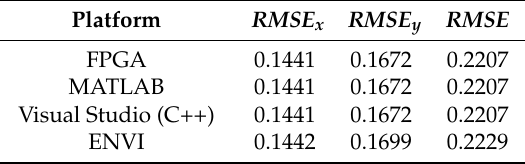
Table 4. Statistics values of the georeferenced image of the first image. Platform